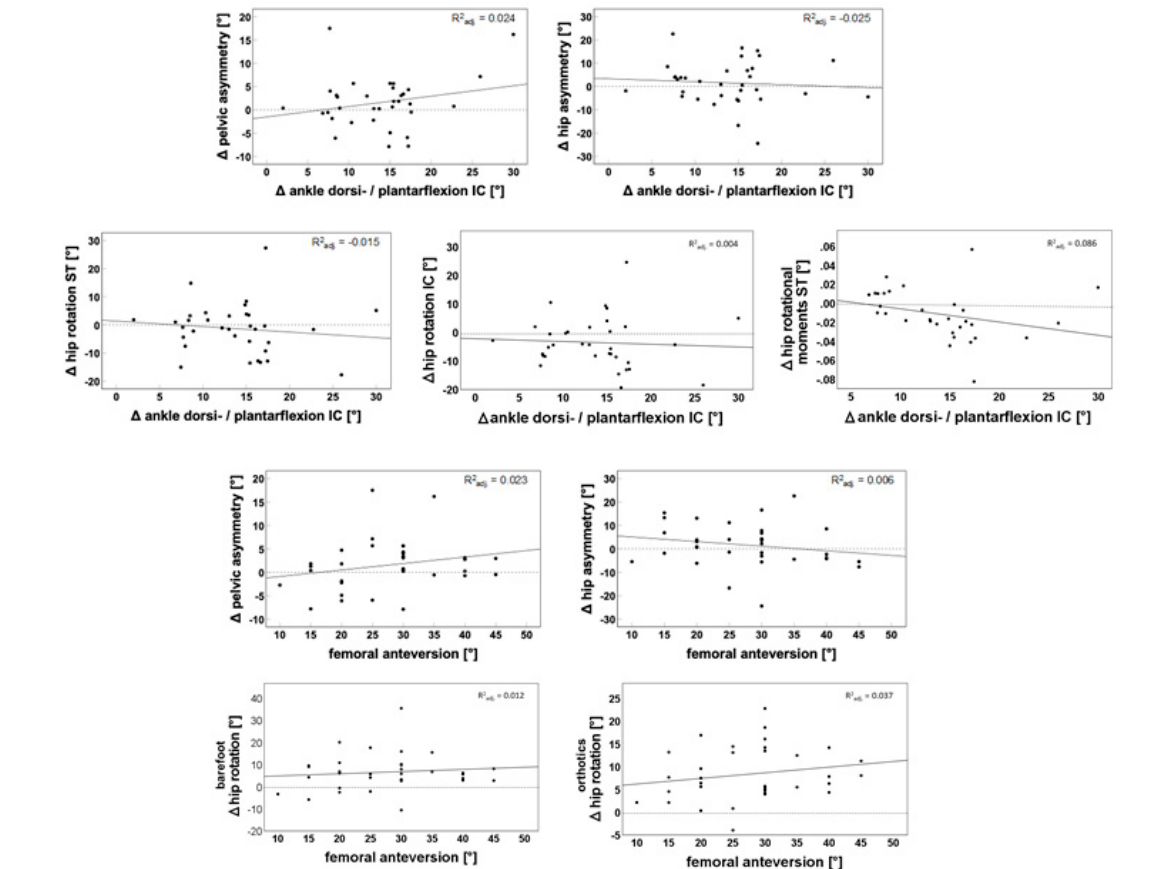
Figure 3. Linear regression of femoral anteversion or changes in pes equinus on changes in pelvic and hip asymmetry, hip rotation, and hip rotational moments. ∆ pelvic asymmetry = barefoot affected side/orthotic affected side; ∆ hip asymmetry = barefoot affected side/orthotic affected side; ∆ hip rotation ST = orthotic affected side/barefoot affected side; ∆ hip rotation IC = orthotic affected side/barefoot affected side; ∆ hip rotational moments ST = orthotic affected side/barefoot affected side; ∆ ankle dorsi/plantar flexion IC = orthotic affected side/barefoot affected side; barefoot ∆ hip rotation = hip rotation 30%/hip rotation IC; orthotics ∆ hip rotation = hip rotation 30%/hip rotation IC; R 2adj = R 2 adjusted. Dotted line: zero line; continuous line: regression line.